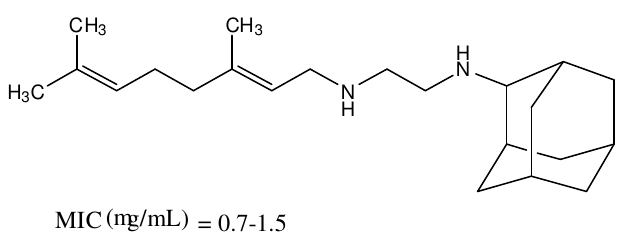
FIGURE 10. Structure of compound